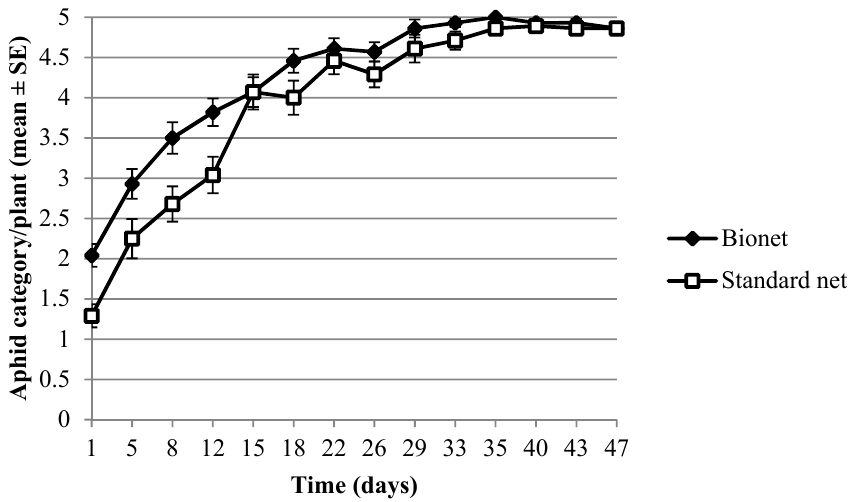
Figure 1. Mean ± SE of the temporal evolution of aphids (scale value), in the nethouses covered with Bionet and Standard net.